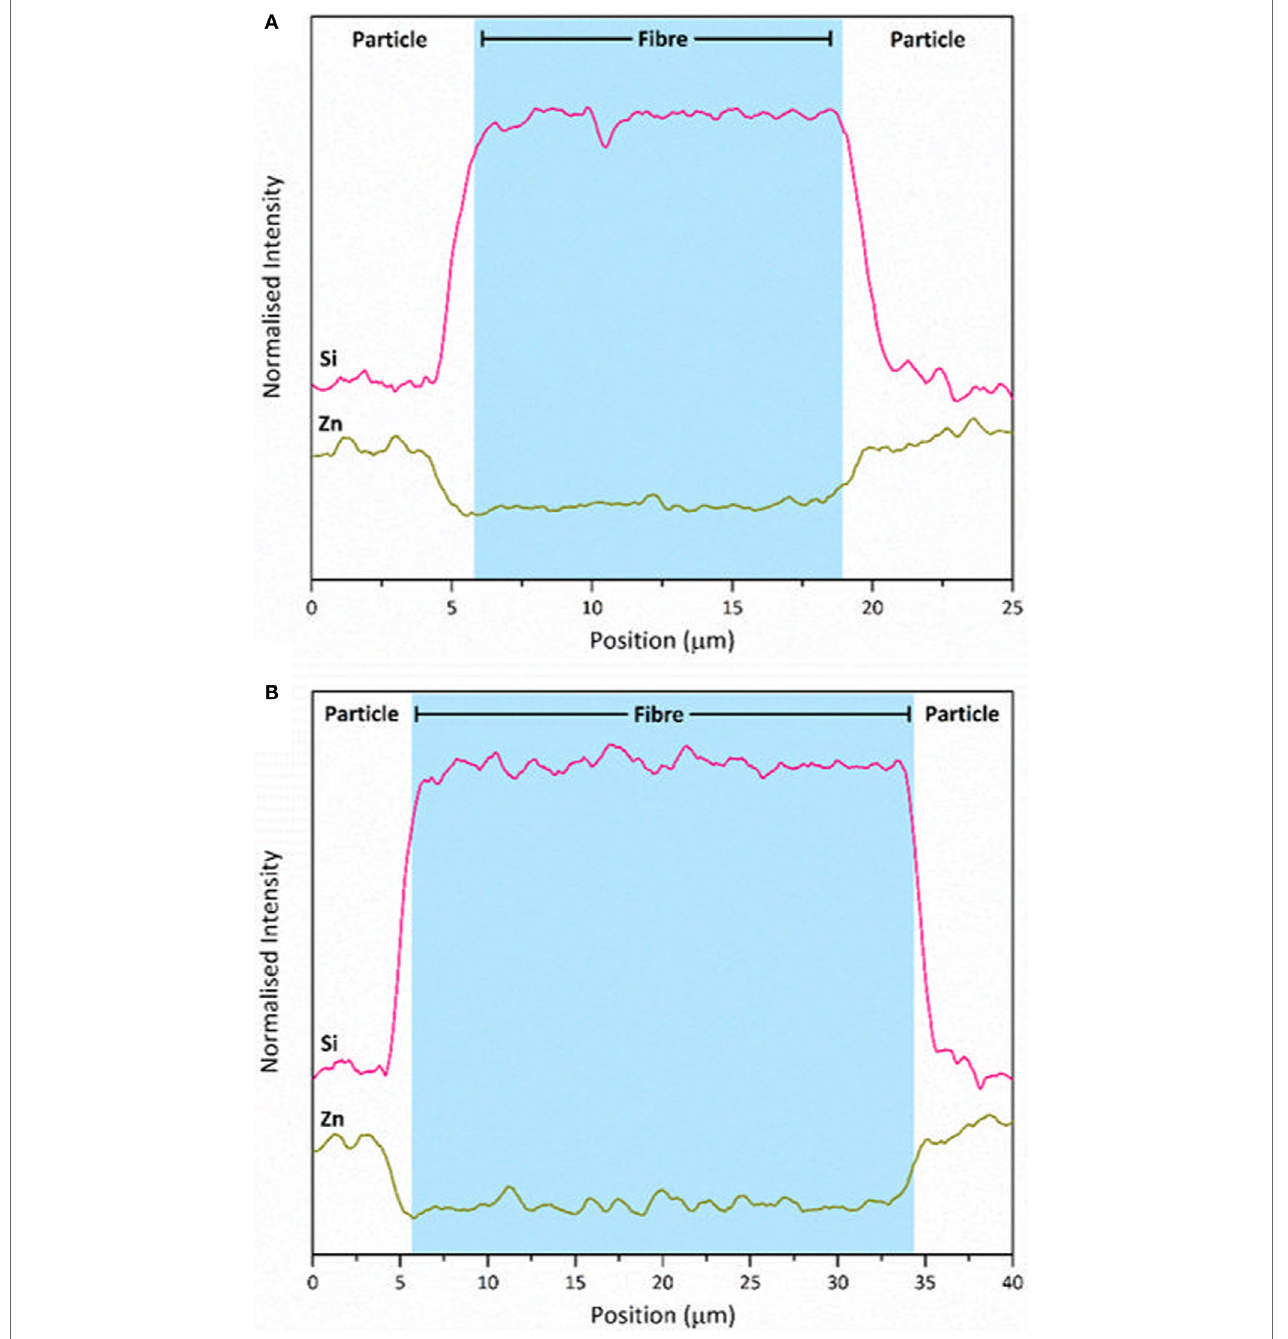
FigUre 3 | Energy dispersive spectroscopy line scans (Si and Zn) across the fibrous features on particle surfaces; (a) line scan over a smaller diameter fiber (as identified in Figure 1a ); (B) line scan over a larger diameter, Si-rich,